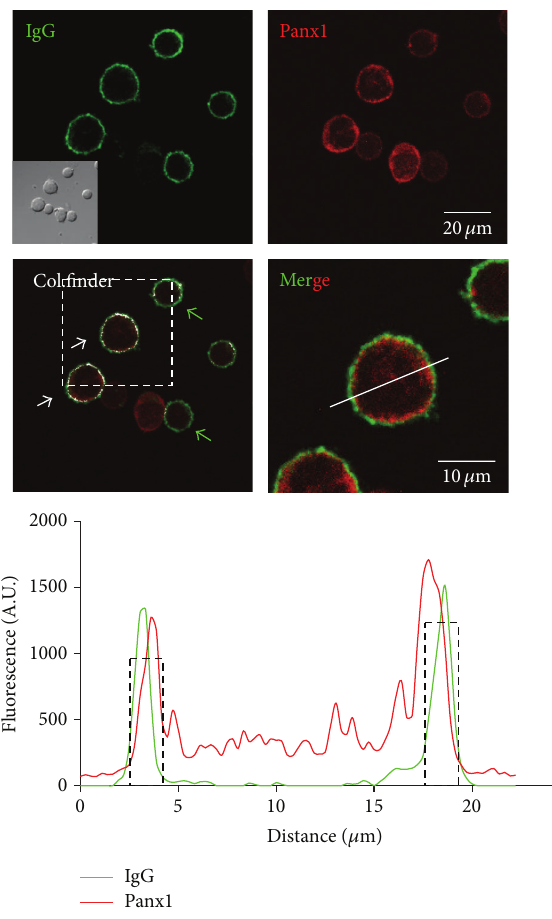
Figure 6: B cells present pannexin1 at the cell surface. Confocal images (Olympus, FluoView FV1000) of immunofluorescence analysis of freshlyisolatedBcellsfixedinethanol(70%).Bcellswereisolatedfromperipherallymphnodesbypositiveselectionfrombalb/cmice.Topleft: B cells were identified with IgG (conjugated to FITC, green); the inset shows the bright field. Top right: pannexin1 (Panx1) immunoreactivity (red, primary antibody: rabbit anti-Panx1 antibody and secondary antibody goat anti-rabbit IgG conjugated to Cy3) is shown. Bar: 20 𝜇 m. Middle left: using ImageJ colocalization finder, it can be seen that Panx1 colocalizes with IgG (white) at the cell surface in some B cells (white arrows). B cells with low or no colocalization are indicated (green arrows). Middle right: zoom and merge of IgG and Panx1 labeling in a B cell denoted by a dotted square at middle left panel. The white line denotes the region used for the line scan. Bar: 10 𝜇 m. Bottom: ImageJ line scan analysis shows the fluorescence intensity of each channel through the white line in the middle of each cell. The peak coincidence (denoted by dotted squares) is an index of colocalization between the different